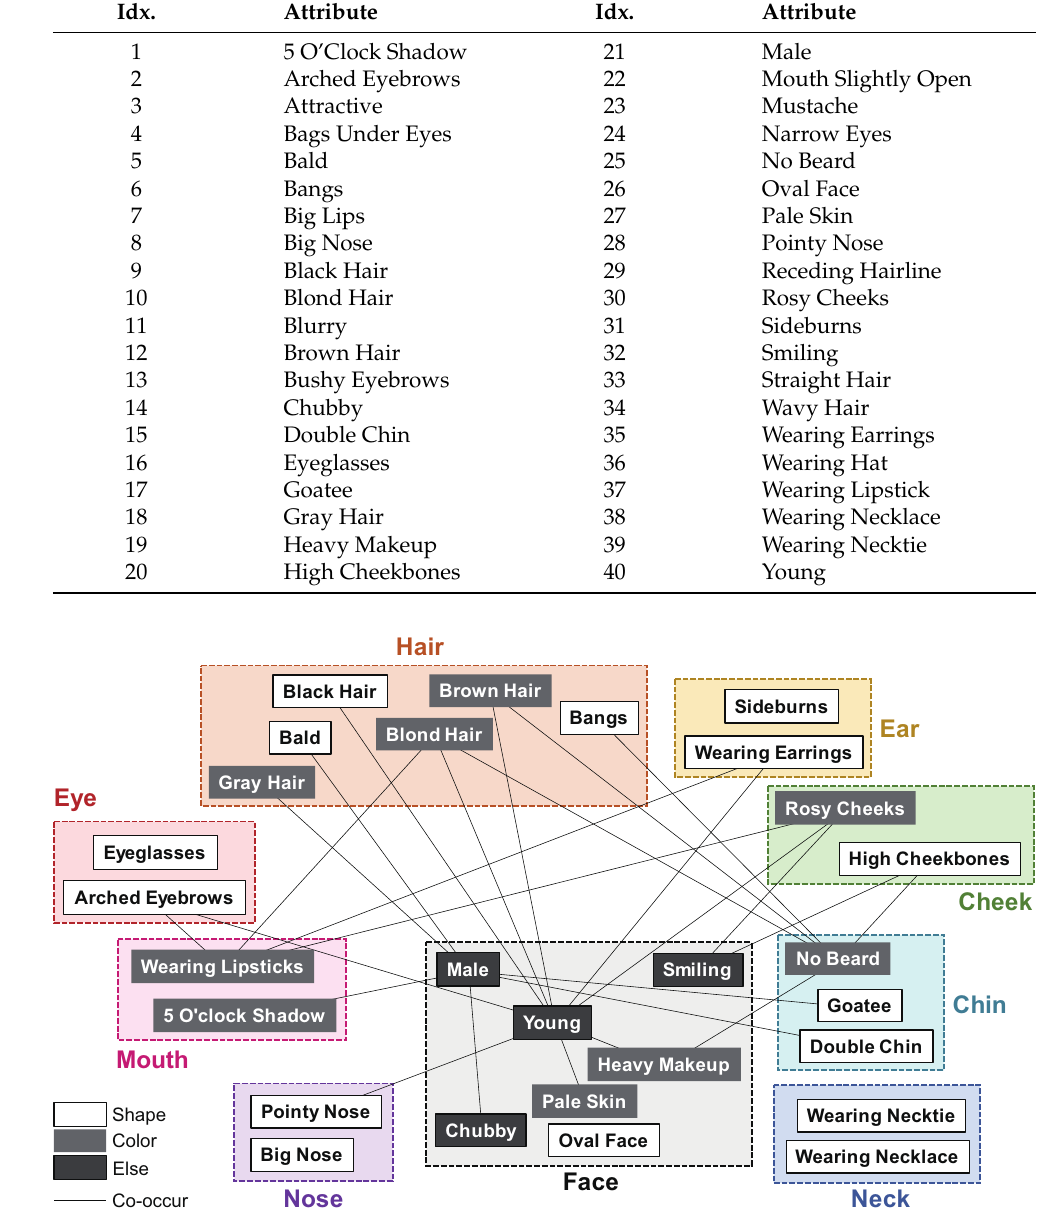
Figure 2. Example of illustrating the relationship among face attributes based on (i) commonality of facial parts, (ii) co-occurrence, and (iii) color, shape, and